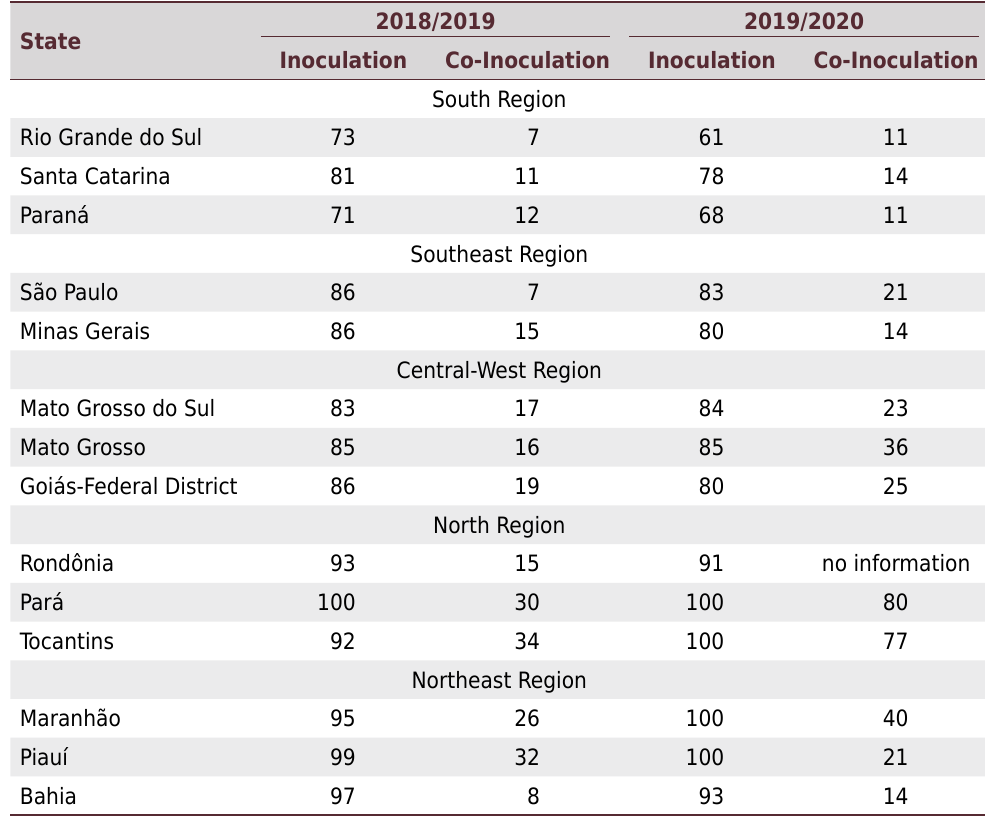
Table 3. Percentage of adoption of soybean single inoculation with Bradyrhizobium spp. and co-inoculation with Bradyrhizobium spp. and Azospirillum brasilense by the Brazilian farmers in the main producing states of Brazil. According to Anpii (Associação Nacional dos Produtores e Importadores de Inoculantes) and Spark smarter